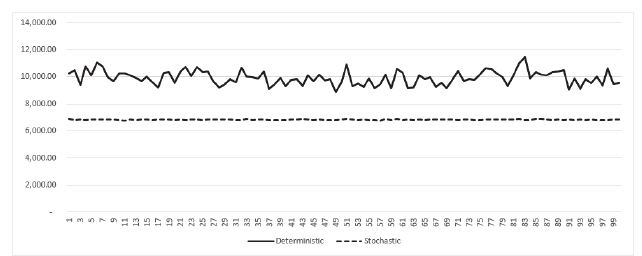
Fig. 3. Comparison between both policies using